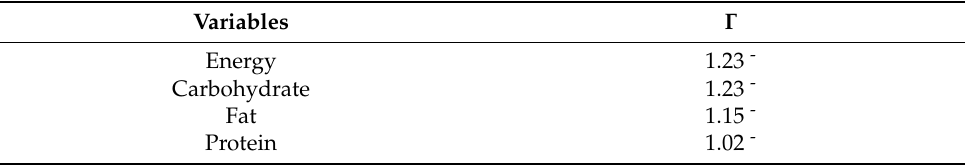
Table A2. The hidden bias test based on Rosenbaum bounds.